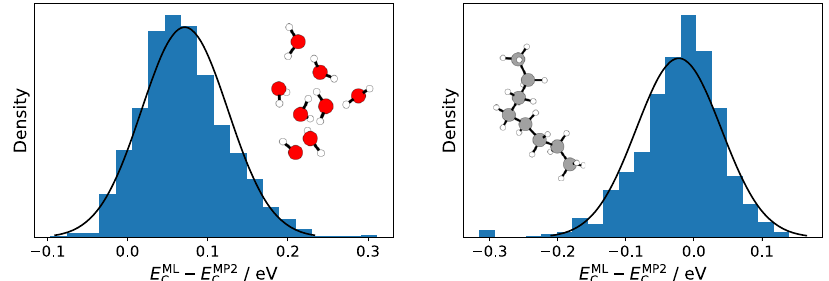
of water octamer (left) and octane con fi gurations (right) C